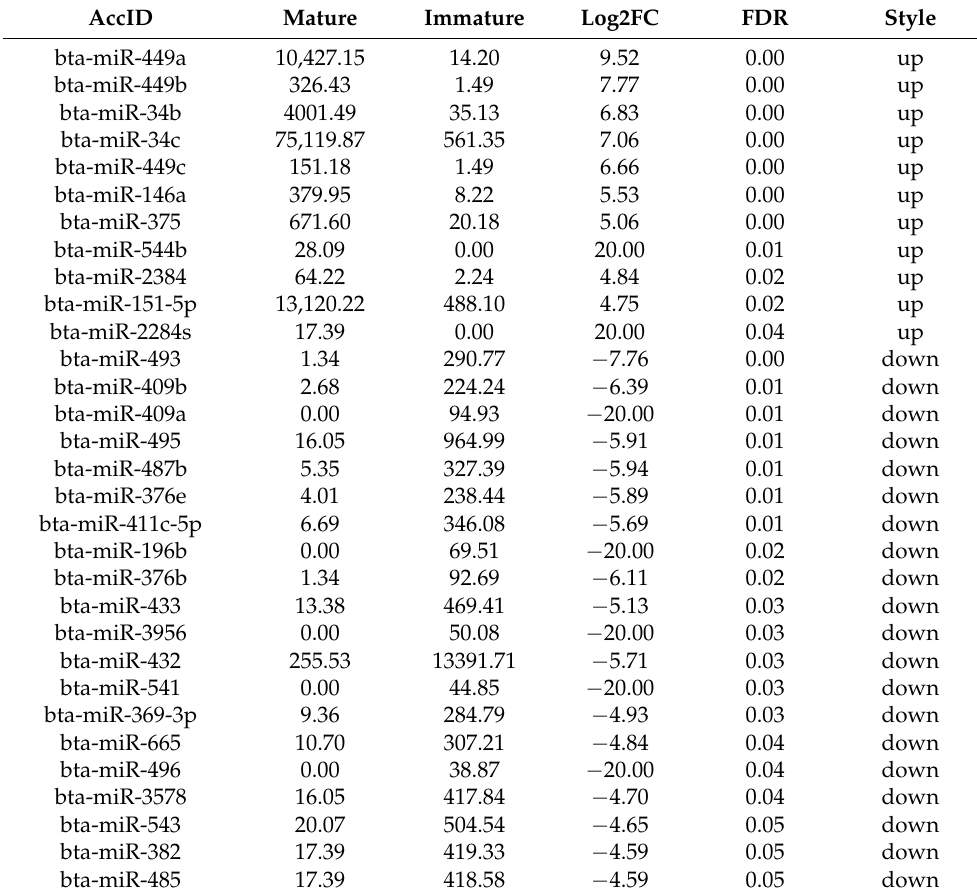
Table 2. Total of 31 differentially expressed miRNAs in the immature and mature testicular